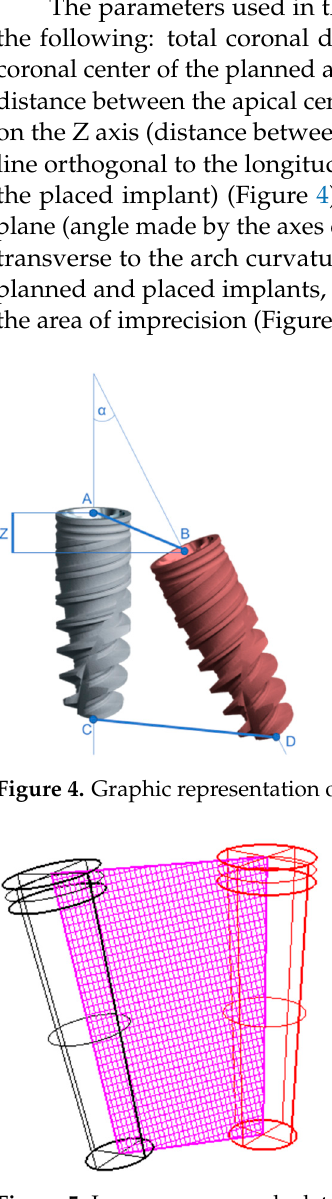
Figure 5. Inaccuracy area calculated between the axes of the implants.